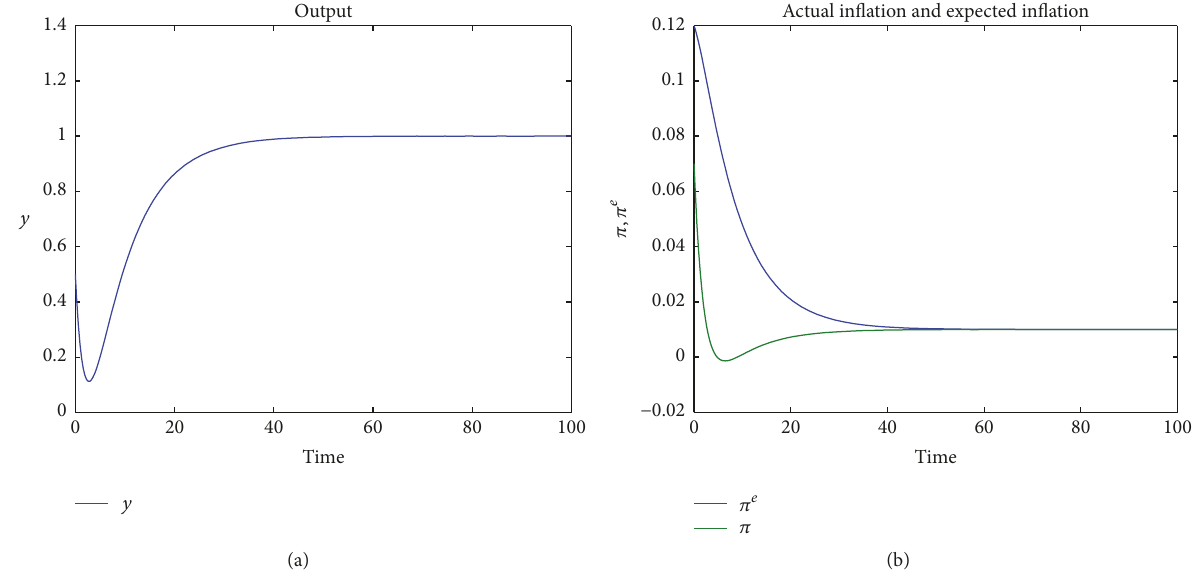
Figure 7: Simulation (4) . (a) Solution for 𝑦(𝑡) . (b) Solutions for 𝜋(𝑡) and 𝜋 𝑒 (𝑡) .